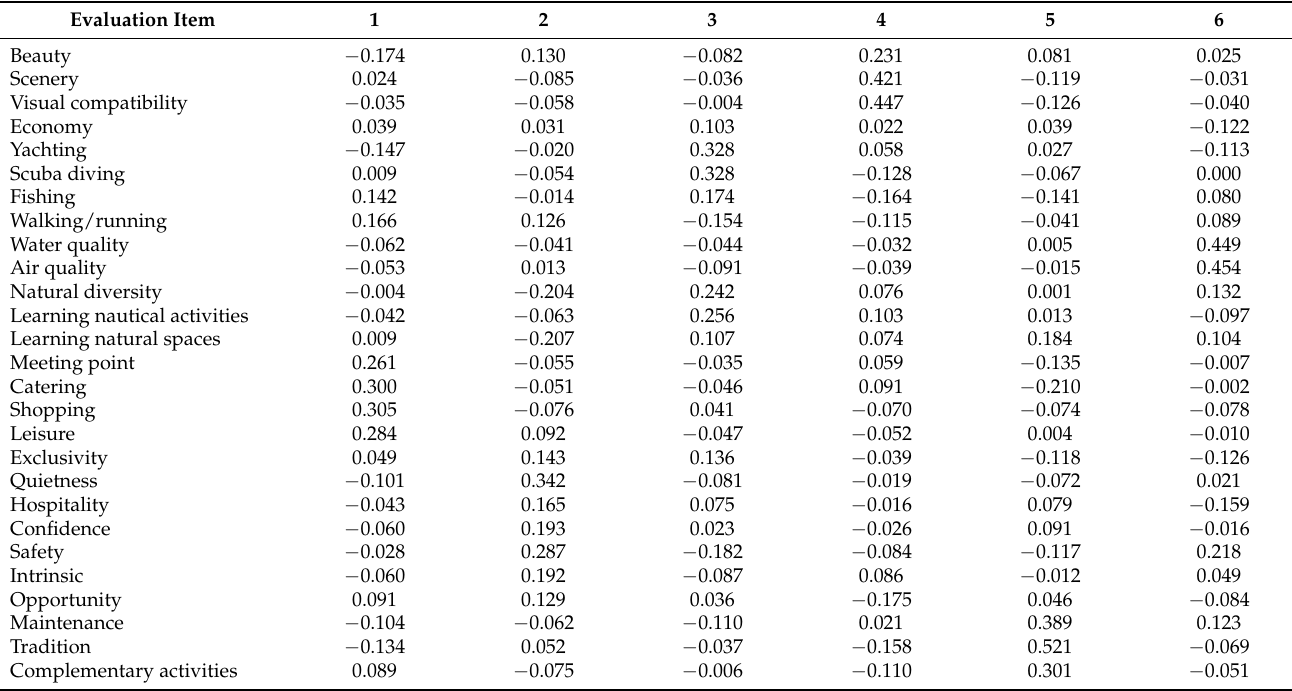
Table A4. Component score coefficient